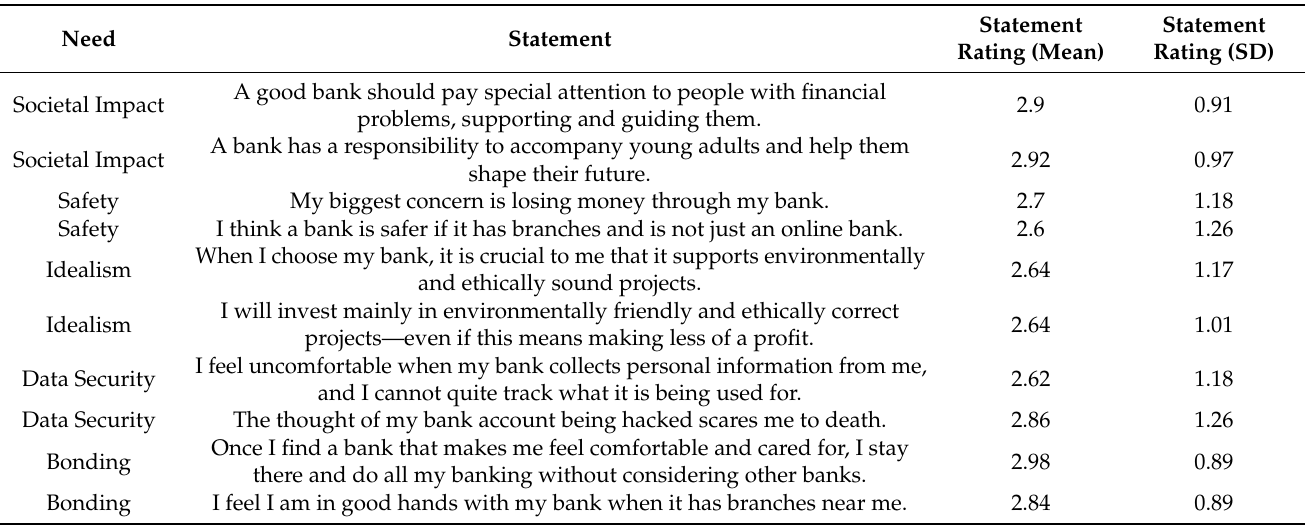
Table 7. Need Statements for the Target Group